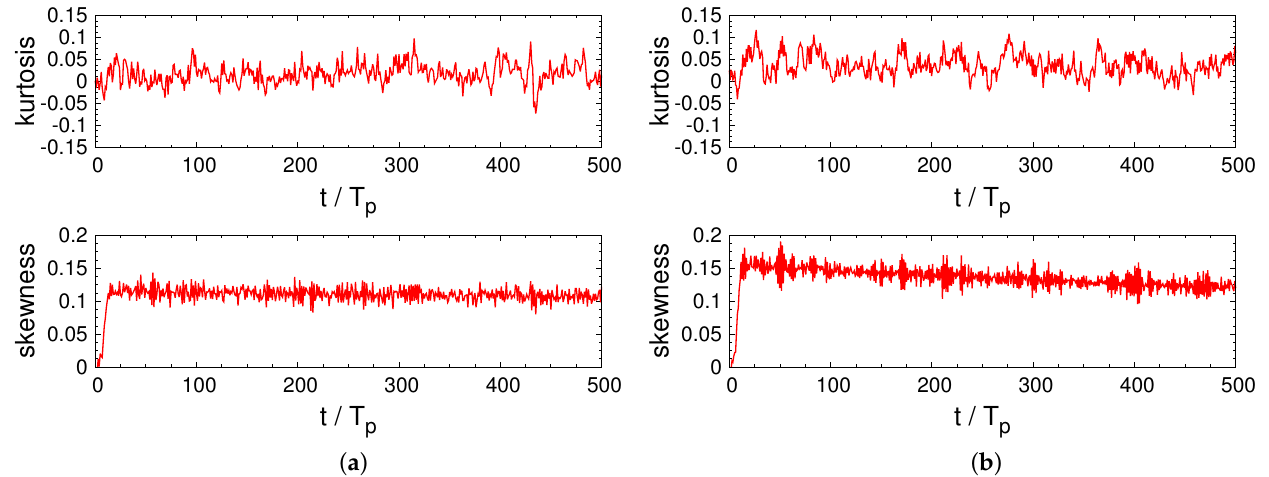
Figure 5. Evolution of skewness and excess kurtosis of the surface elevation: ( a ) case #16, ( b ) case